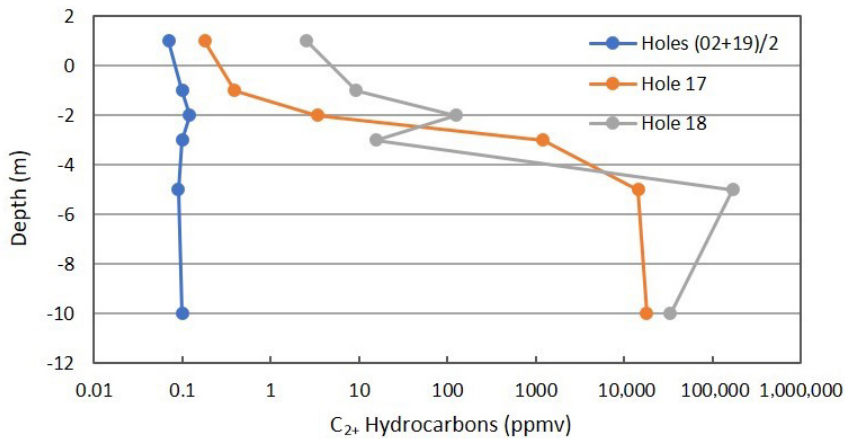
Figure 8. C 2+ profile in combined background locations and Locations 17 and 18 on Fault Zone 2. See Figure 5 for the locations.